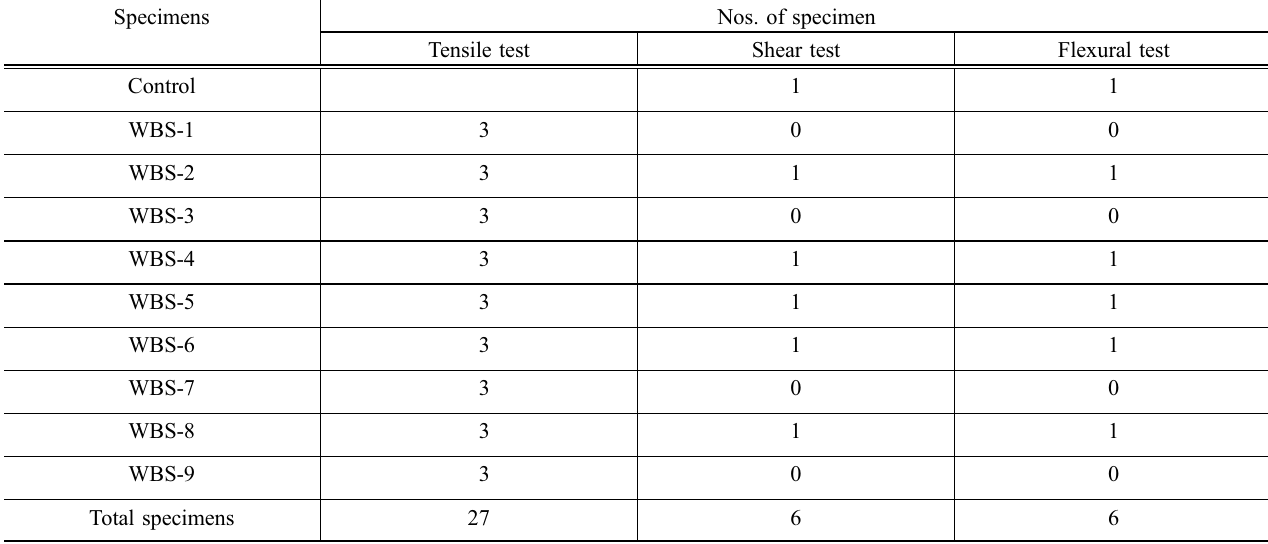
Table 2 Number of specimens tested for each load case.